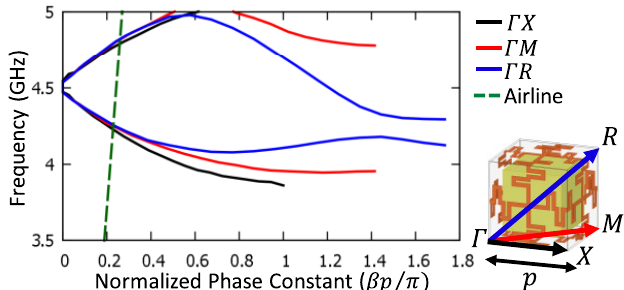
Fig. 8. Simulated dispersion diagram for the composite structure with printed meander-line patterns ( d =1.5 mm).